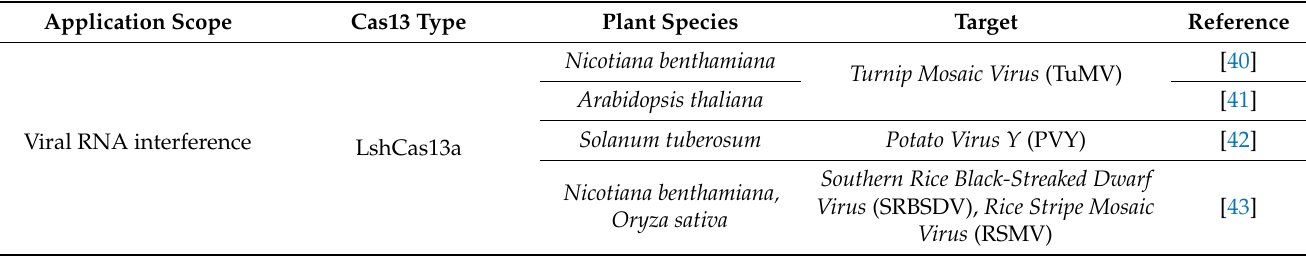
Figure 1. Pictorial representation of CRISPR/Cas13-based RNA technologies. ( a ) RNA interference of virus and RNA targeting using Cas13 to generate virus-resistant plants. ( b ) RNA editing illustration of A to I and C to U conversions when dCas13b is fused with ADAR or ADAR2 enzymes to manipulate a gene’s function and generate transgenic plants with novel traits. ( c ) Alternative splicing (AS) modulation with splicing factor fused to dCas13d to elucidate the function of different alternatively spliced transcripts. ( d ) RNA detection using Cas13-based SHERLOCK method for rapid detection of plant genes and pathogens. Table 2. Summary table of CRISPR/Cas13 applications in